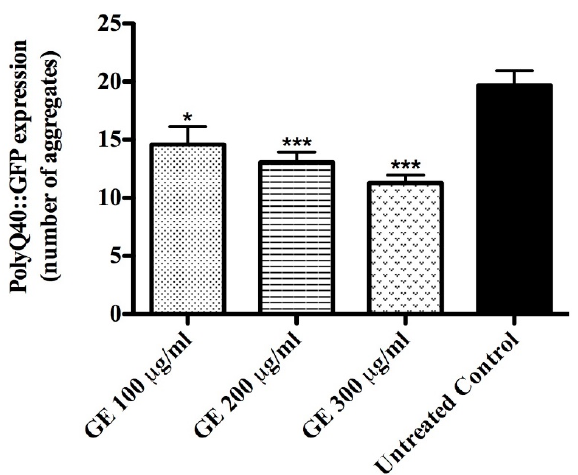
Figure 6. PolyQ40::YFP aggregate accumulation in mutant worms AM141 after GE treatment . Worms treated with GE exhibited significantly lower numbers of polyQ40::GFP aggregates compared to the control group. Data are presented as mean ± SEM. * p <0.05, ** p < 0.01 and *** p < 0.0001 related to the control by a one ‐ way ANOVA followed by Bonferroni (post ‐ hoc).